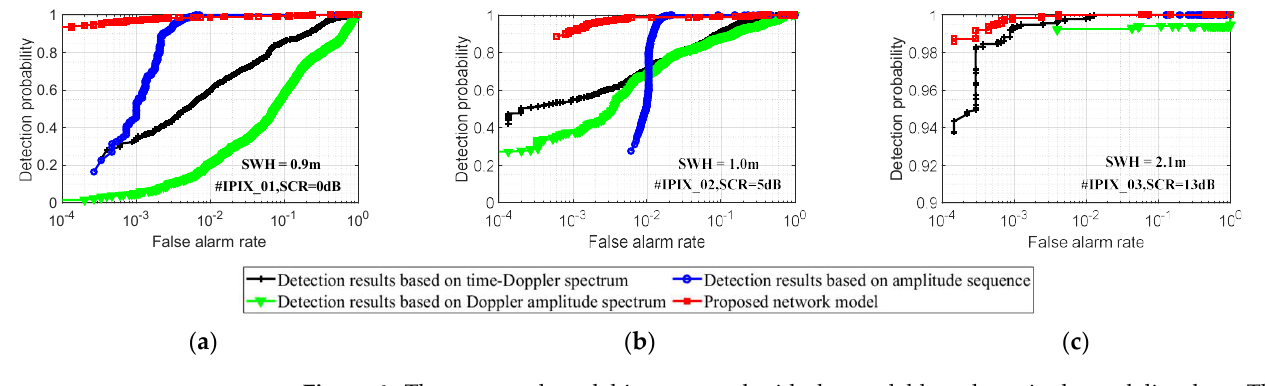
Figure 6. The proposed model is compared with the model based on single-modality data. The detection results are obtained from the test samples and the radar observation time is 0.512 s. ( a ) Lower SCR Sea state; ( b ) Medium SCR Sea state; and ( c ) Higher SCR Sea state.